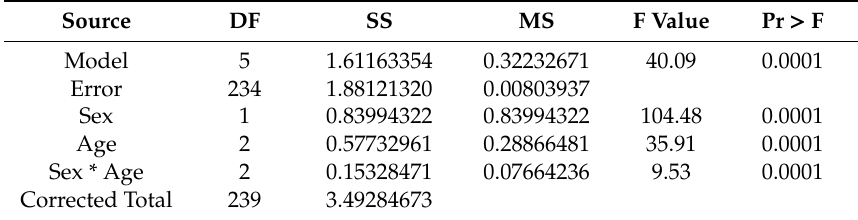
Table 4. The results of the two-way ANOVA for whole-body BMD of males and females according to age.